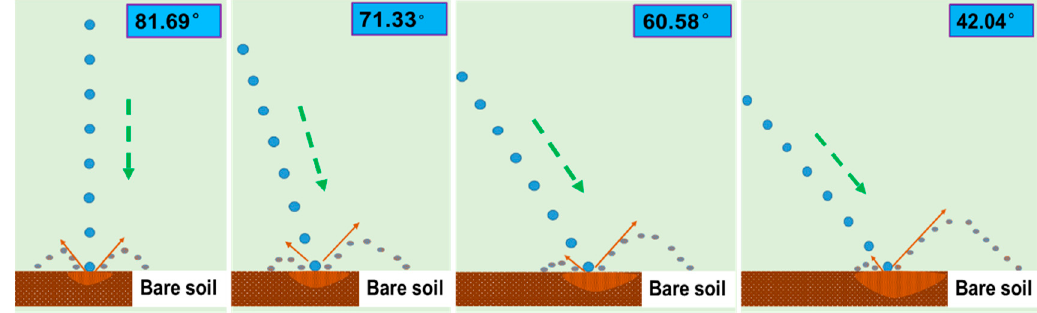
Figure 14. Splash erosion schematic diagram of sprinkler irrigation droplets with different landing angles attacking bare soil.